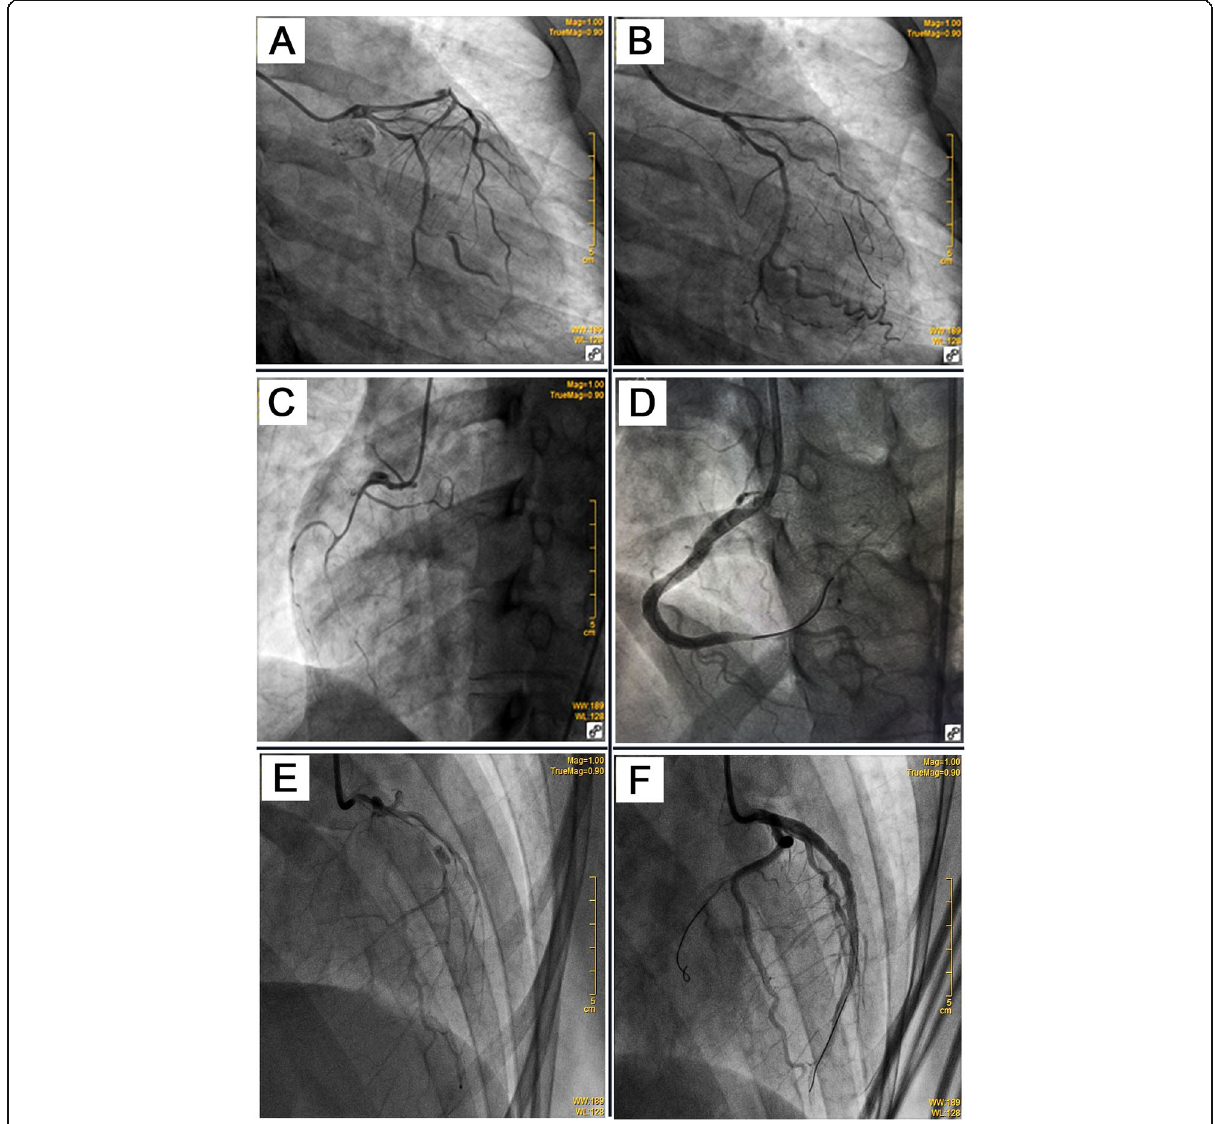
Fig. 2 a Left coronary angiogram showed long diffuse stenosis in LAD and LCX. b The TIMI 3 flow was restored in distal LAD after dilatation with undersized balloons at low-pressure. c Three days after the initial PCI, the MI recurred in this patient. The angiography showed coronary dissection in the ostium of the right coronary artery with TIMI1 flow 1. d No residual stenosis was achieved after implantation with multiple drug- eluting stents from distal to proximal segments of the right coronary artery. e Three days later, the patient suffered from MI again. Coronary angiogram demonstrated long diffuse stenosis in LAD and LCX with TIMI flow 3. f Multiple drug-eluting stents were implanted into focal lesions of LAD, LCX, and LMC arteries to seal intimal tears and achieve the optimal results of no residual stenosis and restoration of TIMI 3 flow. LAD: left anterior descending coronary artery; LCX: left circumflex coronary artery; LMC: left main coronary artery; TIMI: Thrombolysis